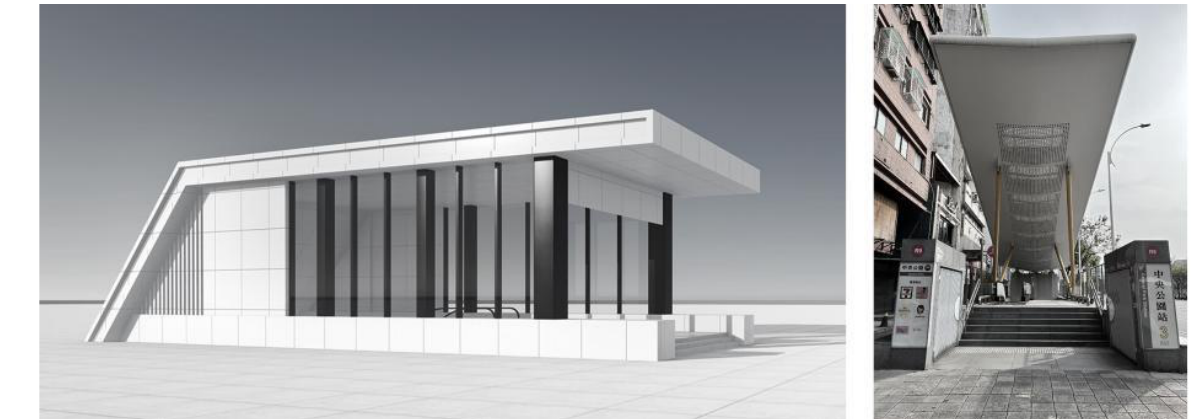
Figure 1. Fully closed and semiclosed entrance pavilions.